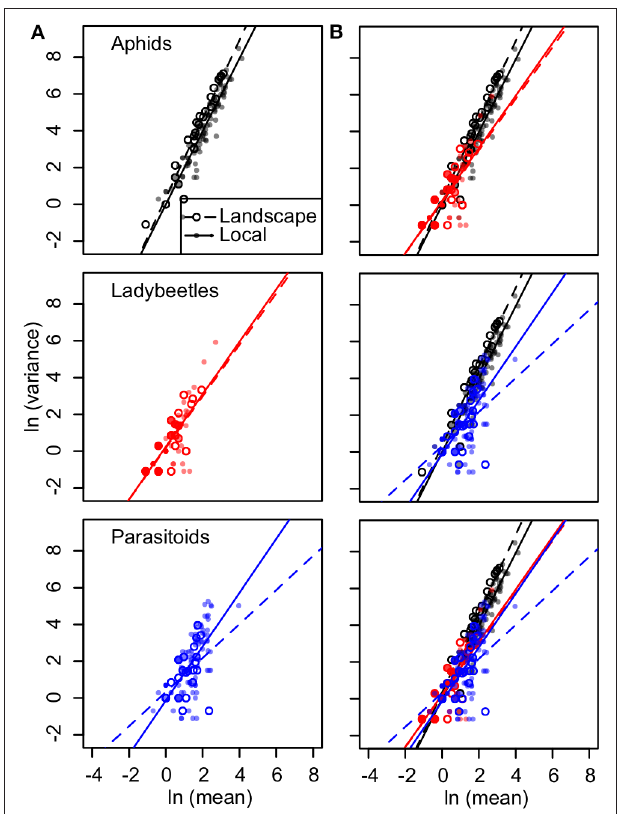
FIGURE 6 | (A) Linear regressions to calculate Taylor’s temporal law for abundances of aphids (black), ladybird beetles (red), and parasitoid wasps (blue) at landscape (open circles) and local plots (solid points). For aphids, slopes = 2.14, 1.98, R 2 = 0.92, 0.88, P < 0.001 for both; ladybird beetles, slopes = 1.40, 1.42, R 2 = 0.65, 0.68, P < 0.001 for both; and parasitoid wasps, slopes = 0.92, 1.46, R 2 = 0.20, 0.45, P = 0.13 and P < 0.001 for landscape and local plot sample points, respectively. (B) Plots are repeated and overlaid in different combinations to visually compare arthropod